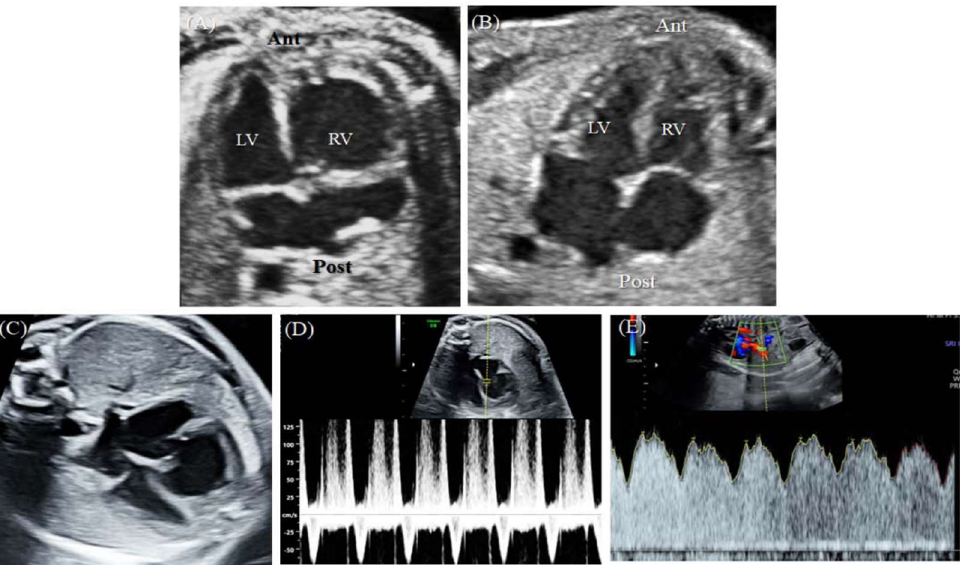
Figure 1. This is a figure. Schemes follow the same formatting . ( A ) At 26 +2 weeks GA, the upper fetus showed globular RV enlargement compared with ( B ) the lower fetus, who had a normal heart. ( C ) At 30 +5 weeks GA, the globular shape of the RV remained unchanged, but ( D ) holosystolic TR was observed. ( E ) Doppler evaluation of the ductus venosus showed normal findings. Ant, anterior; Lt, left; LV, left ventricle; Post, posterior; Rt, right; RV, right ventricle. At a GA of 35 +2 weeks, the globular RV of the upper fetus persisted (Figure 2 A).